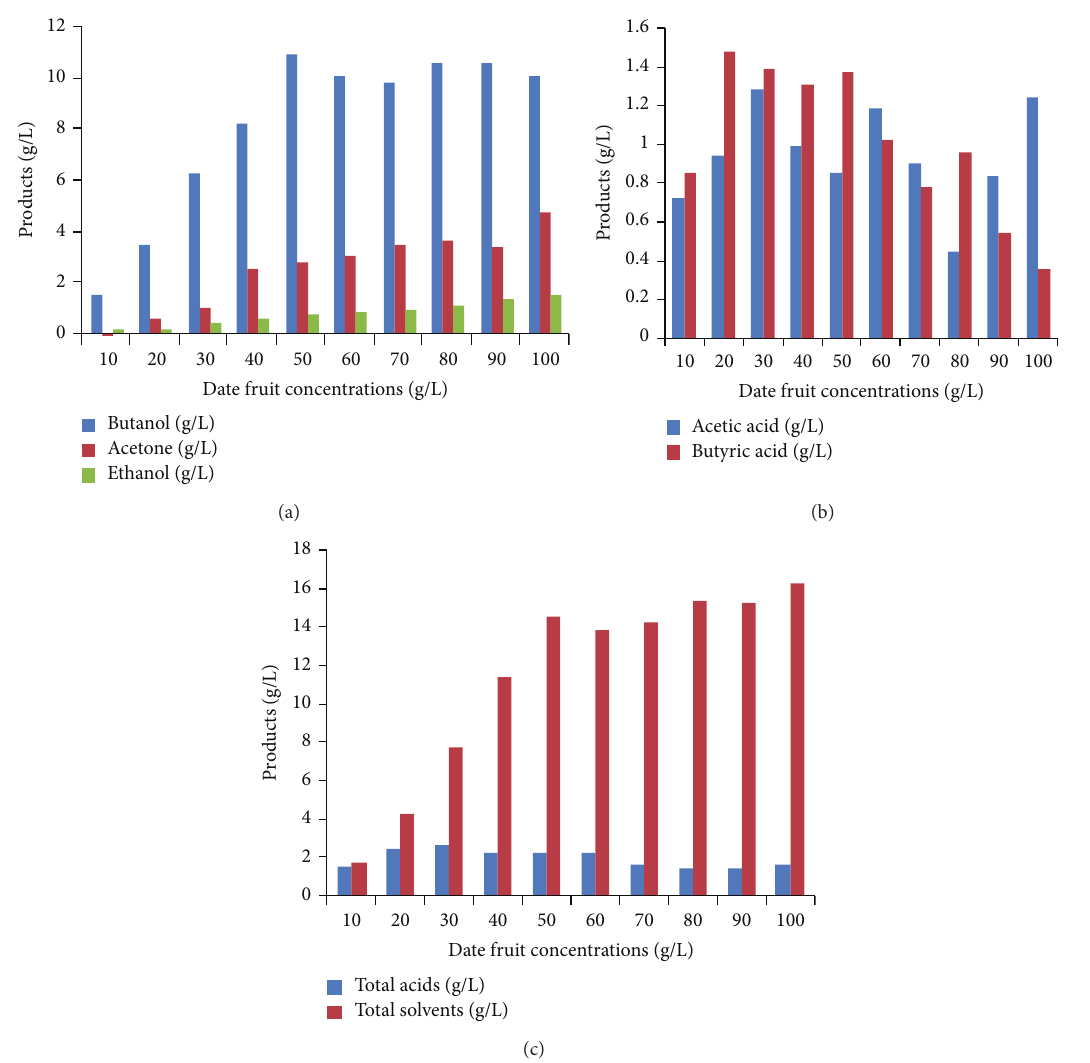
Figure 1: ABE fermentation by C. acetobutylicum NCIMB 13557: (a) production of butanol, ethanol, and acetone, (b) production of acetic acid and butyric acid, and (c) total acids and total solvents